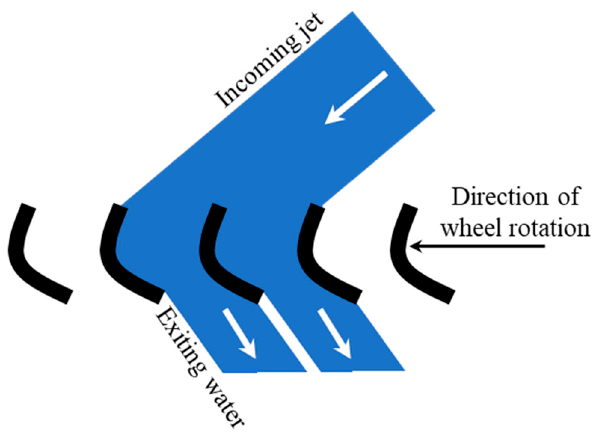
Figure 2. Diagram showing the interaction between the jet and the Turgo blade, adapted from [20].